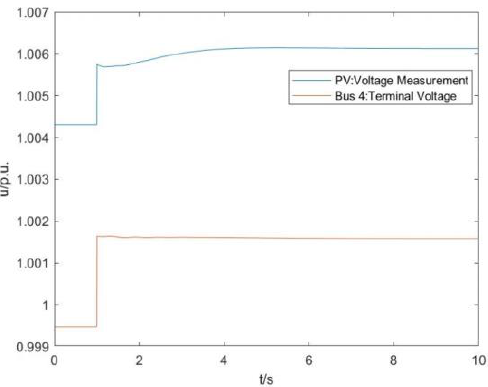
Figure 15. Voltage changes of key nodes in the system(consider VSG only).